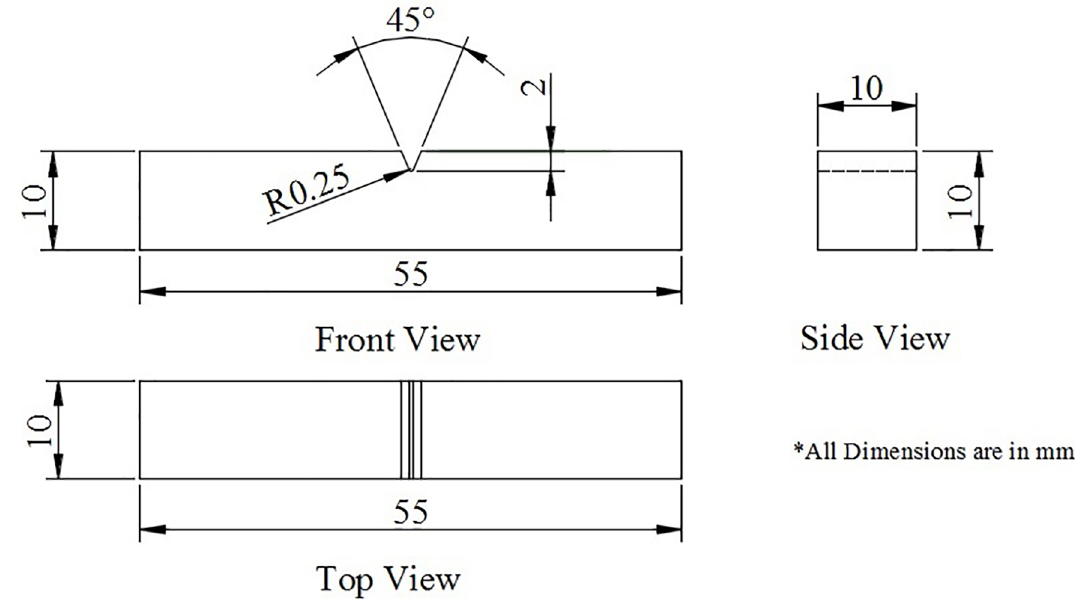
Figure 3. Impact test specimen